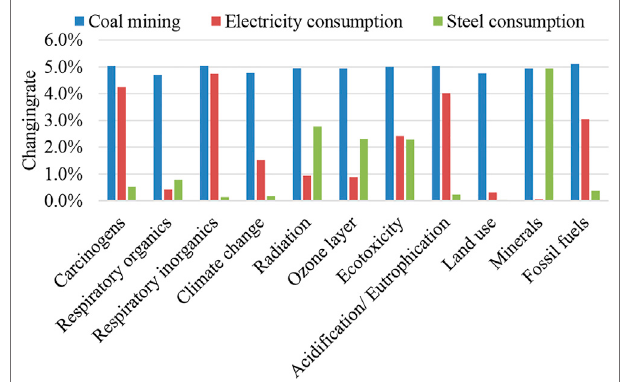
FIGURE 9 | Sensitivity analysis results of key